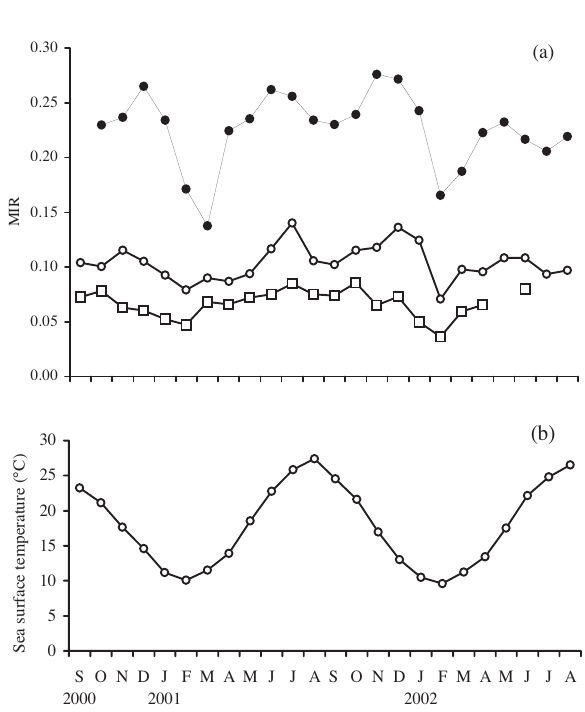
F IG . 3. – Monthly means of marginal increment ratio (MIR) for age I (solid circles), II (open circles) and III (open squares), for round sardinella (a), and sea surface temperature (°C) in the area (b) between September 2000 and August